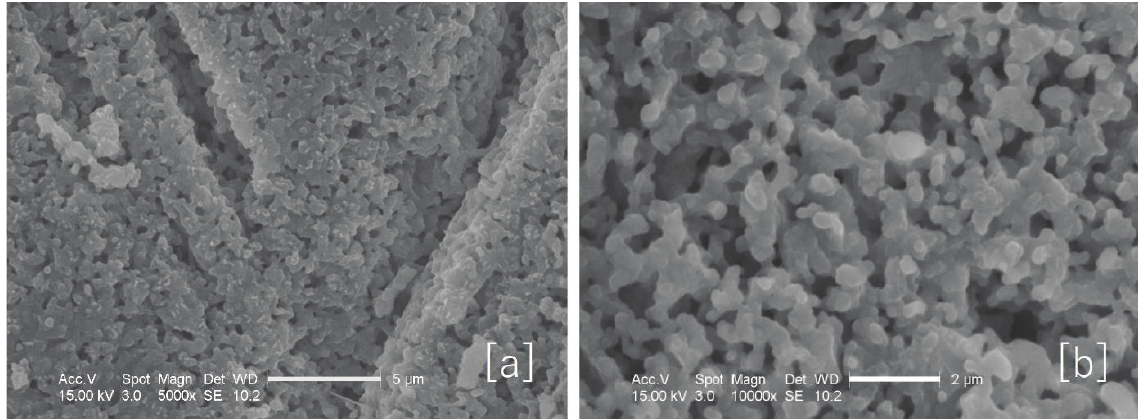
Fig. 6 Surface of the SO grain after thermal activation at 373 K, BSE, magnification: a)